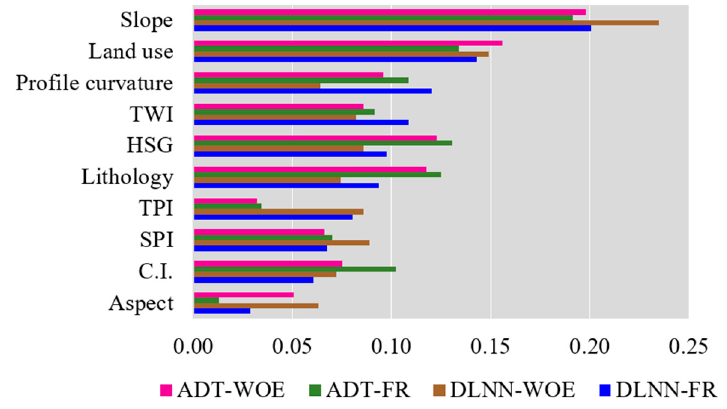
Figure 9. Flash-flood predictors importance.